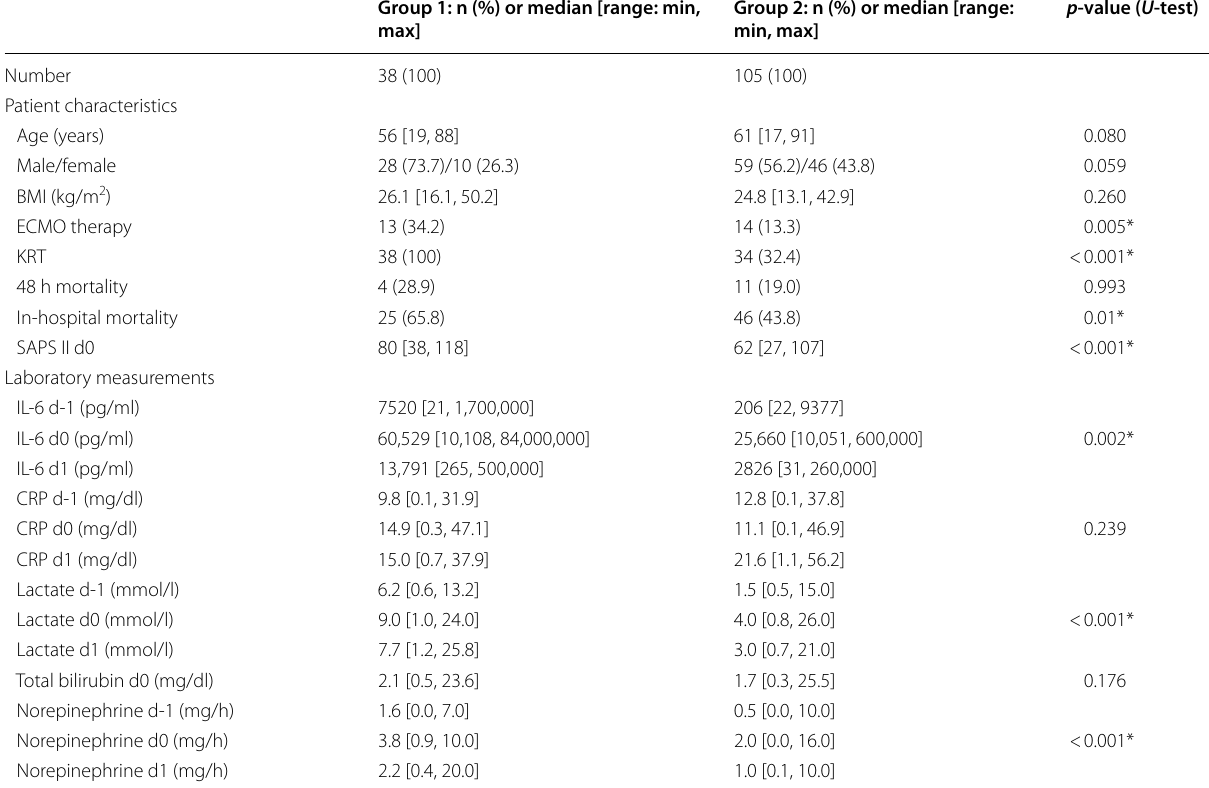
Table 1 Patient characteristics and laboratory measurements in both groups before